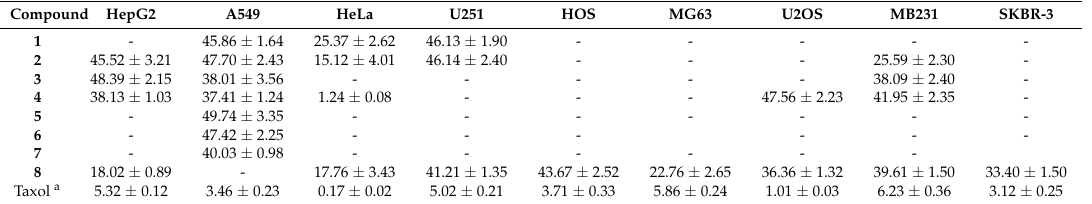
Table 3. IC 50 values ( µ M) of cytotoxicity for eight compounds against nine human cancer cell lines. Compound HepG2 A549 HeLa U251 HOS MG63